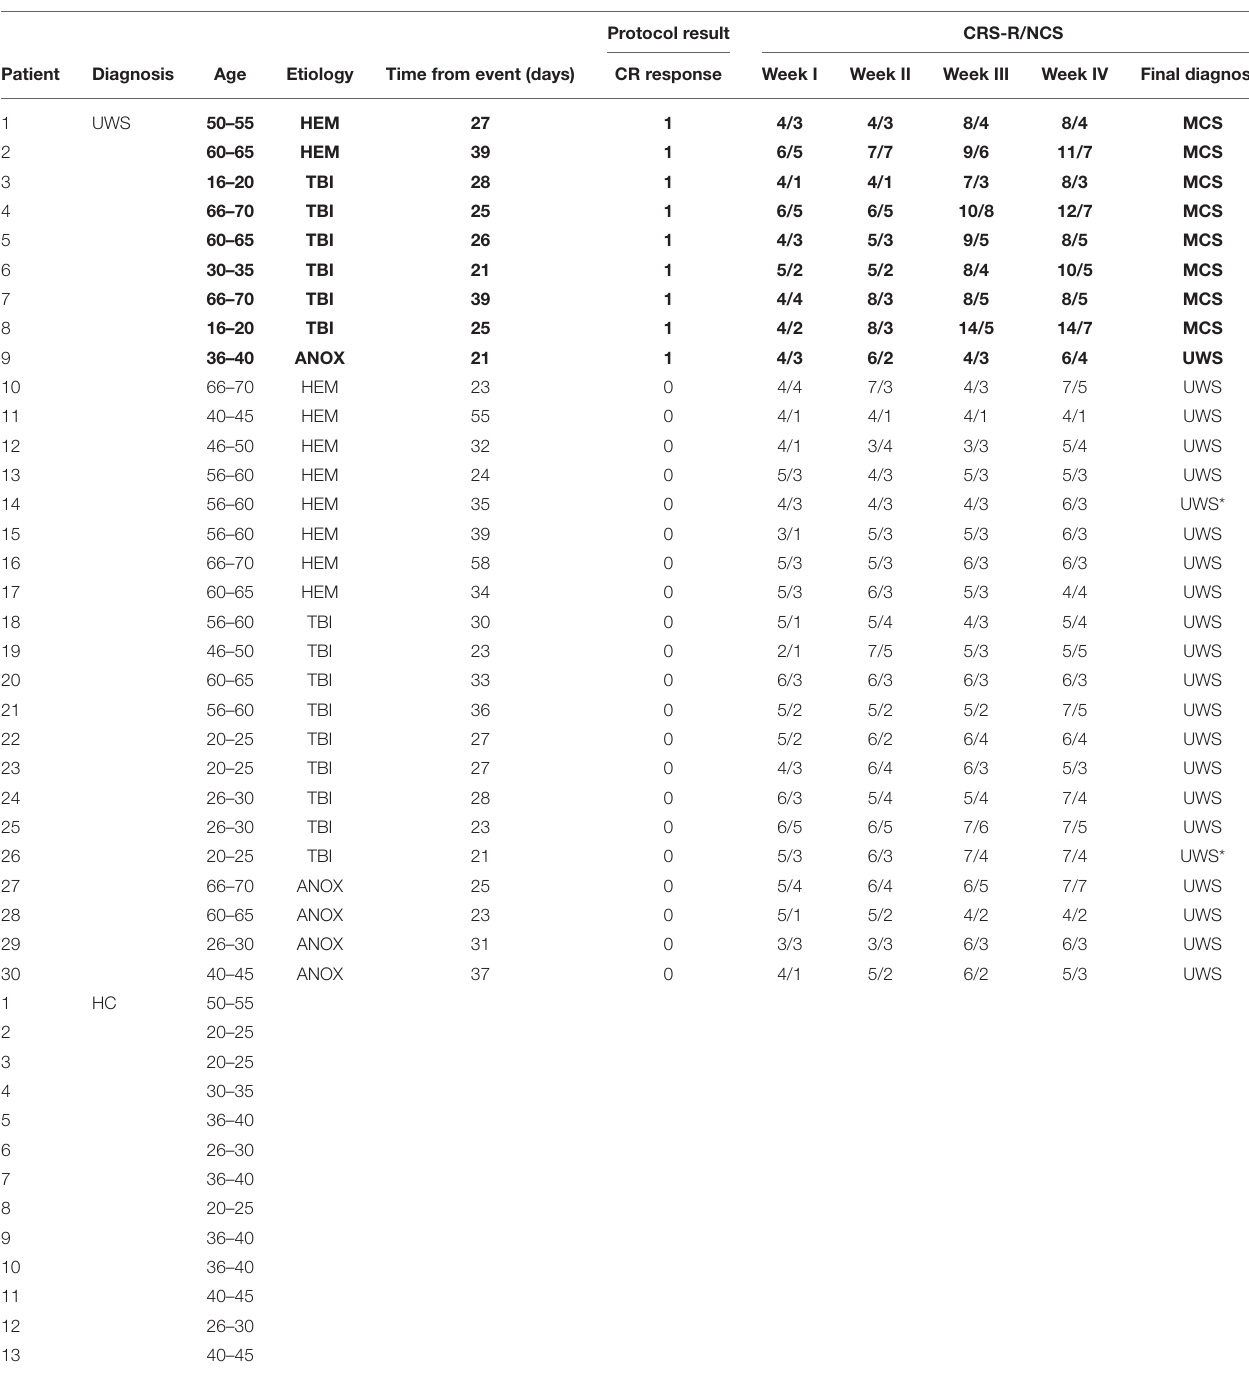
TABLE 1 | Demographic information of groups, test results and CRS-R/NCS assessments of UWS patients.